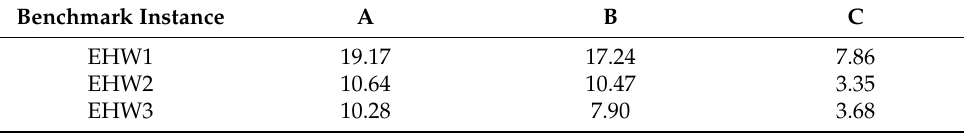
Table 13. Dif. ref-avg (%).